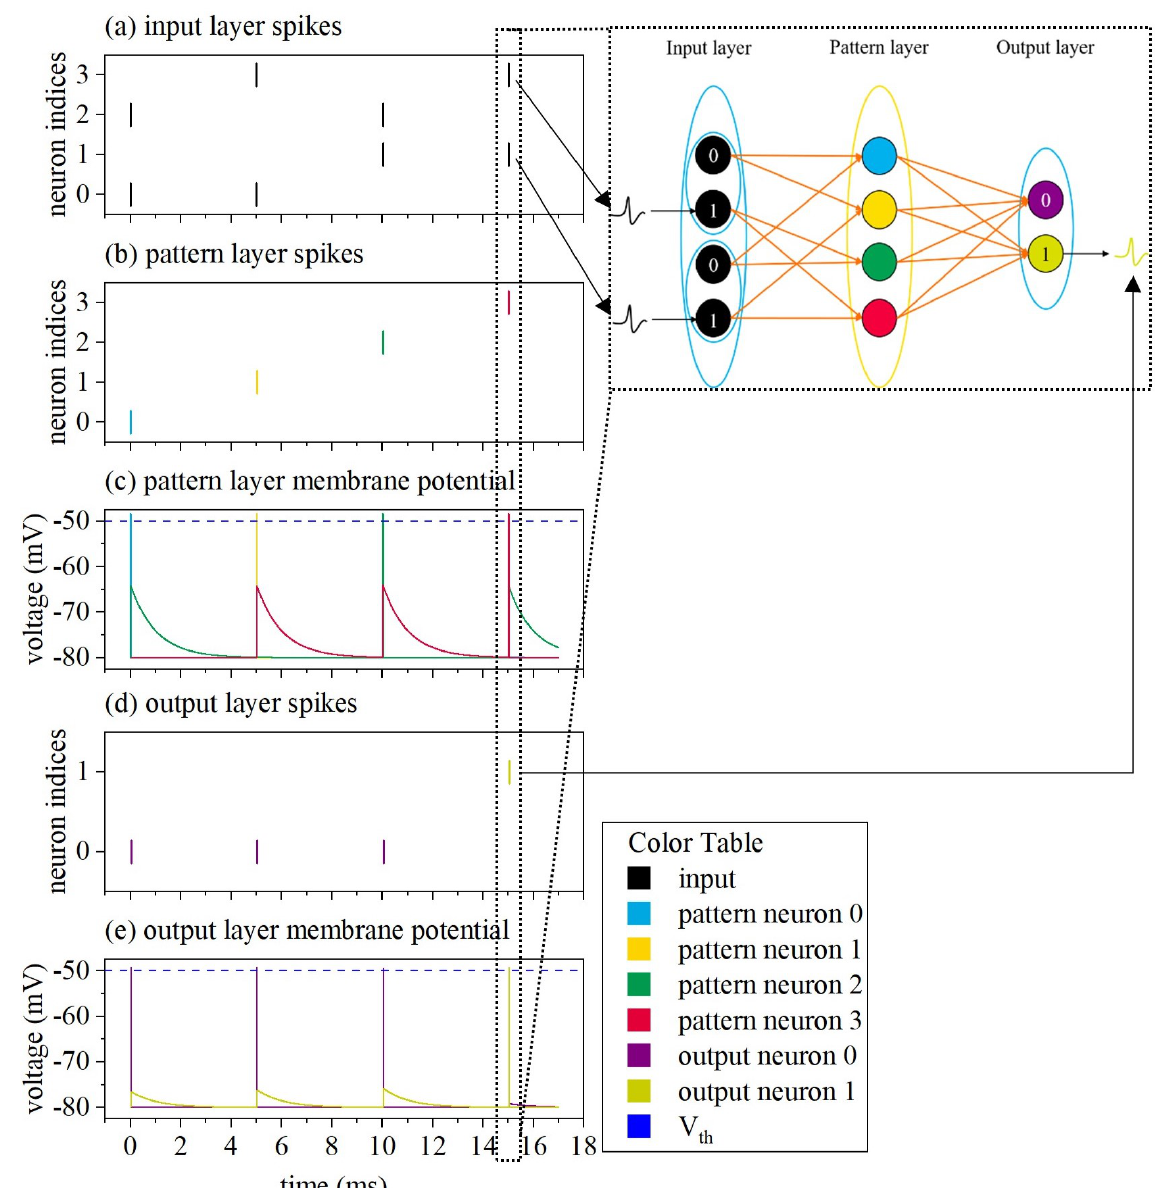
Figure 6. The test result of the SNN logical operation module AND. ( a – e ) The input layer spikes, the pattern layer spikes, the pattern layer membrane potential, the output layer spikes, and the output layer membrane potential,